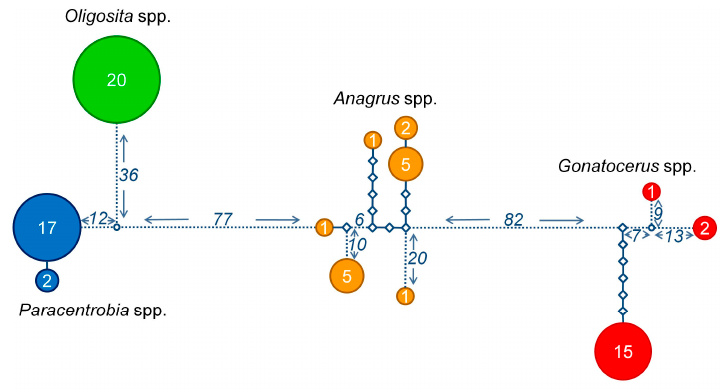
Figure 3. Overall 28S rRNA haplotype distances. Network representing the number of substitutions between the different 28S rRNA gene sequences obtained from different parasitoid genera: Paracentrobia (blue ) ; Oligosita (green); Anagrus (orange); and Gonatocerus (red). The sample size for each haplotype is written in the respective circle. Each diamond represents a substitution. The numbers next to the dotted lines are the number of substitutions not represented in detail in the figure.